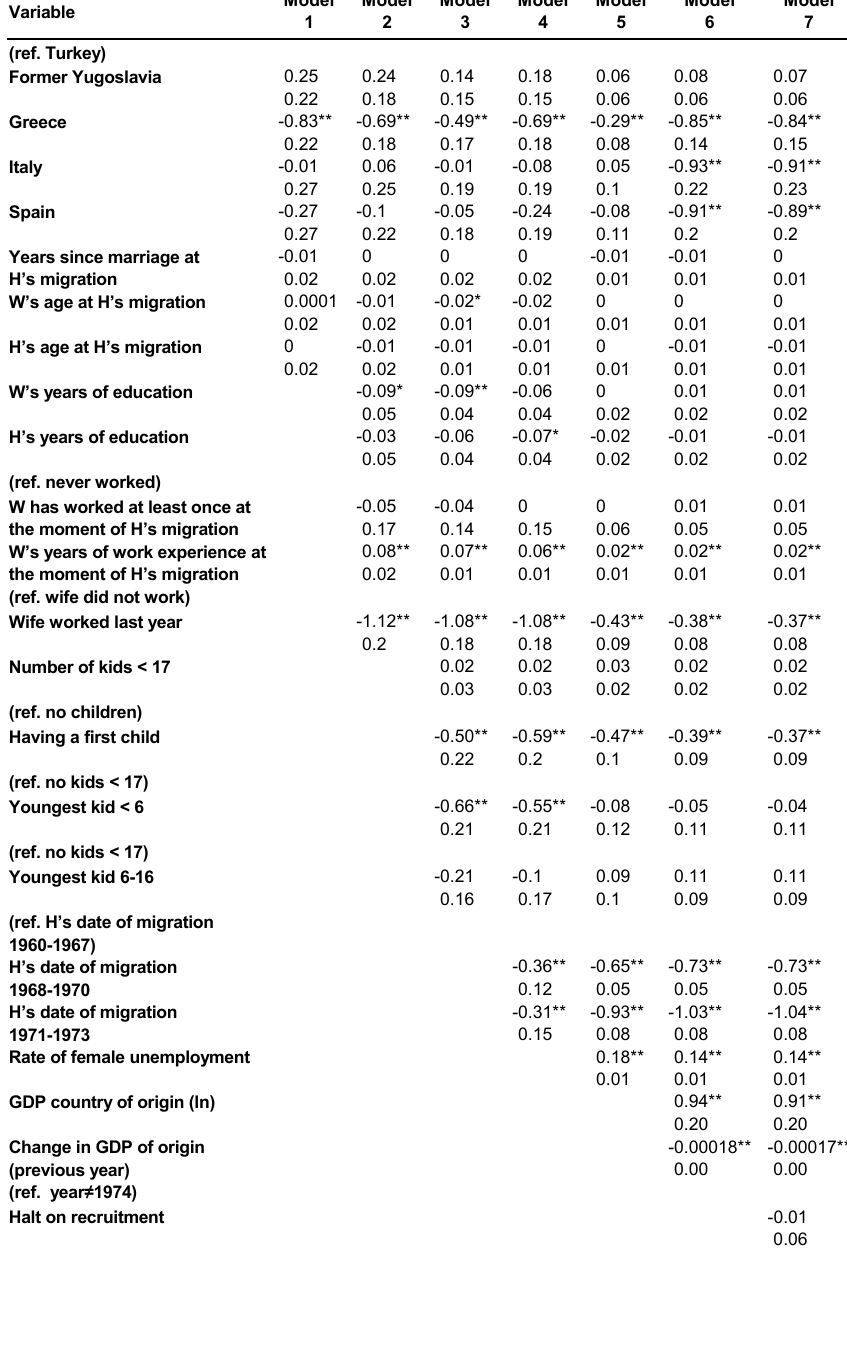
Table 4. Estimates of wife’s reunification (Weibull accelerated failure time